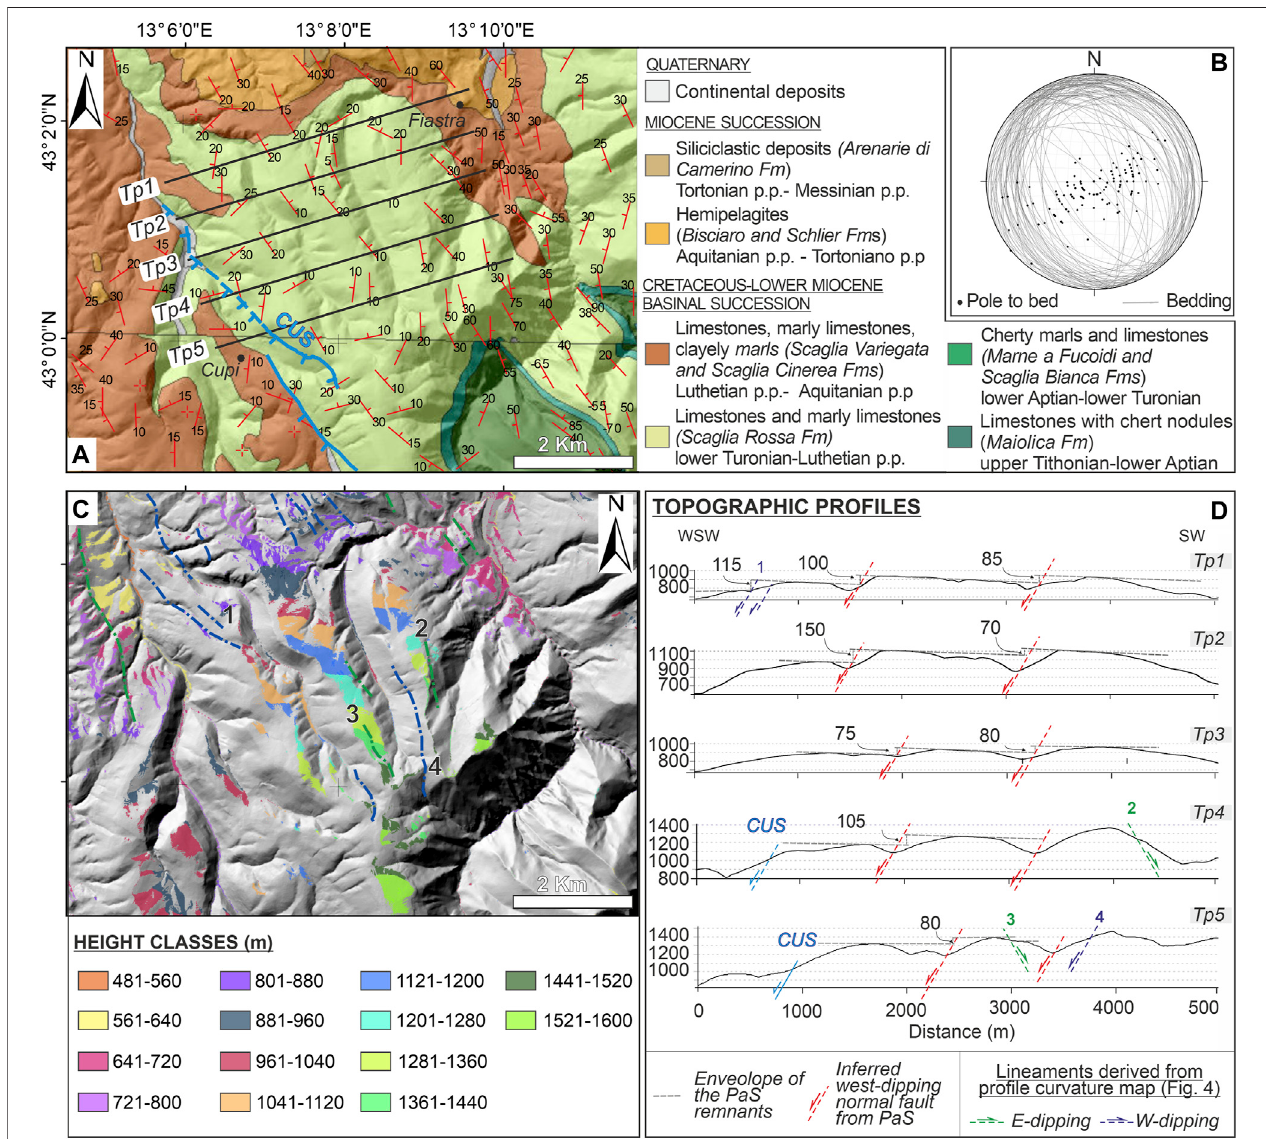
FIGURE 5 | Morphometric- and morphotectonic analysis of the Cupi-Mt Val di Fibbia sector (inset b in Figure 1B ). (A) Geological map of the sector with the main outcropping stratigraphic units as derived from the Carta Geologica d ’ Italia at scale 1:100,000 (Regio Uf fi cio Geologico, 1941; Servizio Geologico d ’ Italia, 1967). The pro fi le traces from 1 to 5 refer to the topographic pro fi les (Tp1 to Tp5) shown in the panel (D) . (B) Lower-hemisphere Schmidt projection of the bedding as reported for the sector, with poles. (C) Map the of height-classes showing colour-coded elevation ranges computed combining slope- and aspect derivative analysis (see text for detail). (D) Topographic pro fi les (along the traces in panel (A) ) showing the top of the paleosurface remnants (PaS) and their lowering toward the south-west. Black numbers refer to the possible vertical offsets (in meters) of the morphological marker. Bold colored numbers refer to the interpreted lineaments from the curvature analysis as in Figure 4B . CUS (cid:1) Cupi-Ussita sections of the VBF (as in Brozzetti et al., 2019).